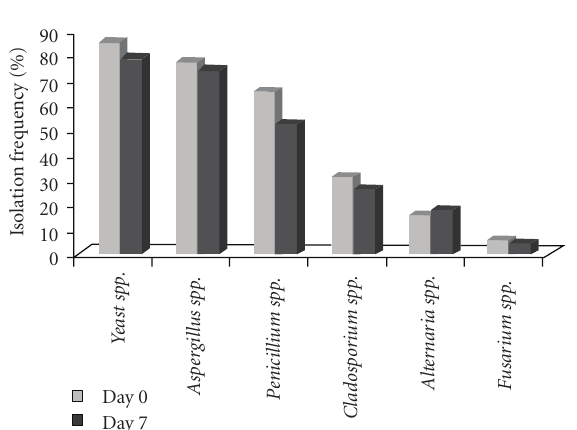
Figure 2: Isolation frequency (%) of di ff erent fungal genera isolated from brewer’s grains at days 0 and 7 of